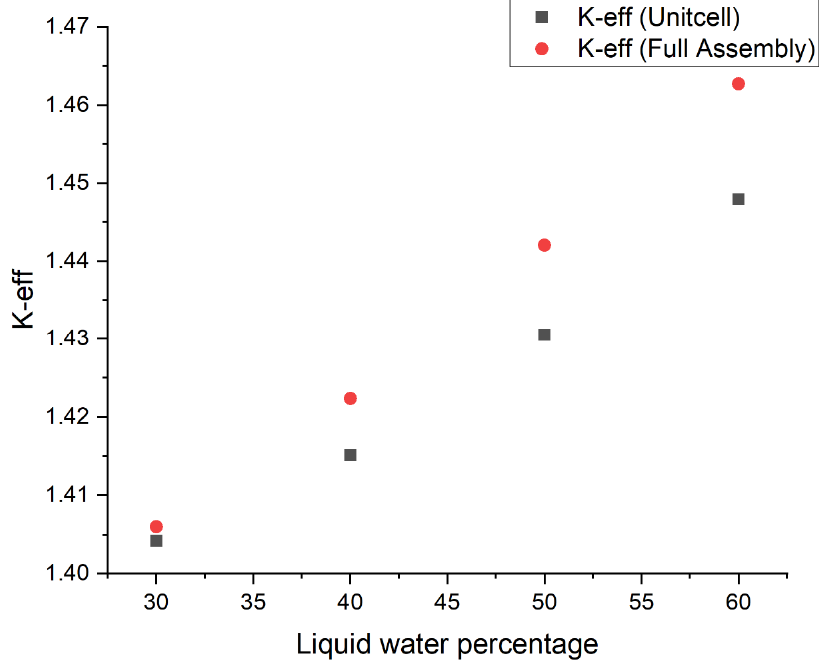
Figure 14. Effect of areas of increased moderation on the criticality of the radial model. At lower void fractions the effect is shown to be greater, up to a difference around 1000 pcm at the lowest void fraction of 60% water density.